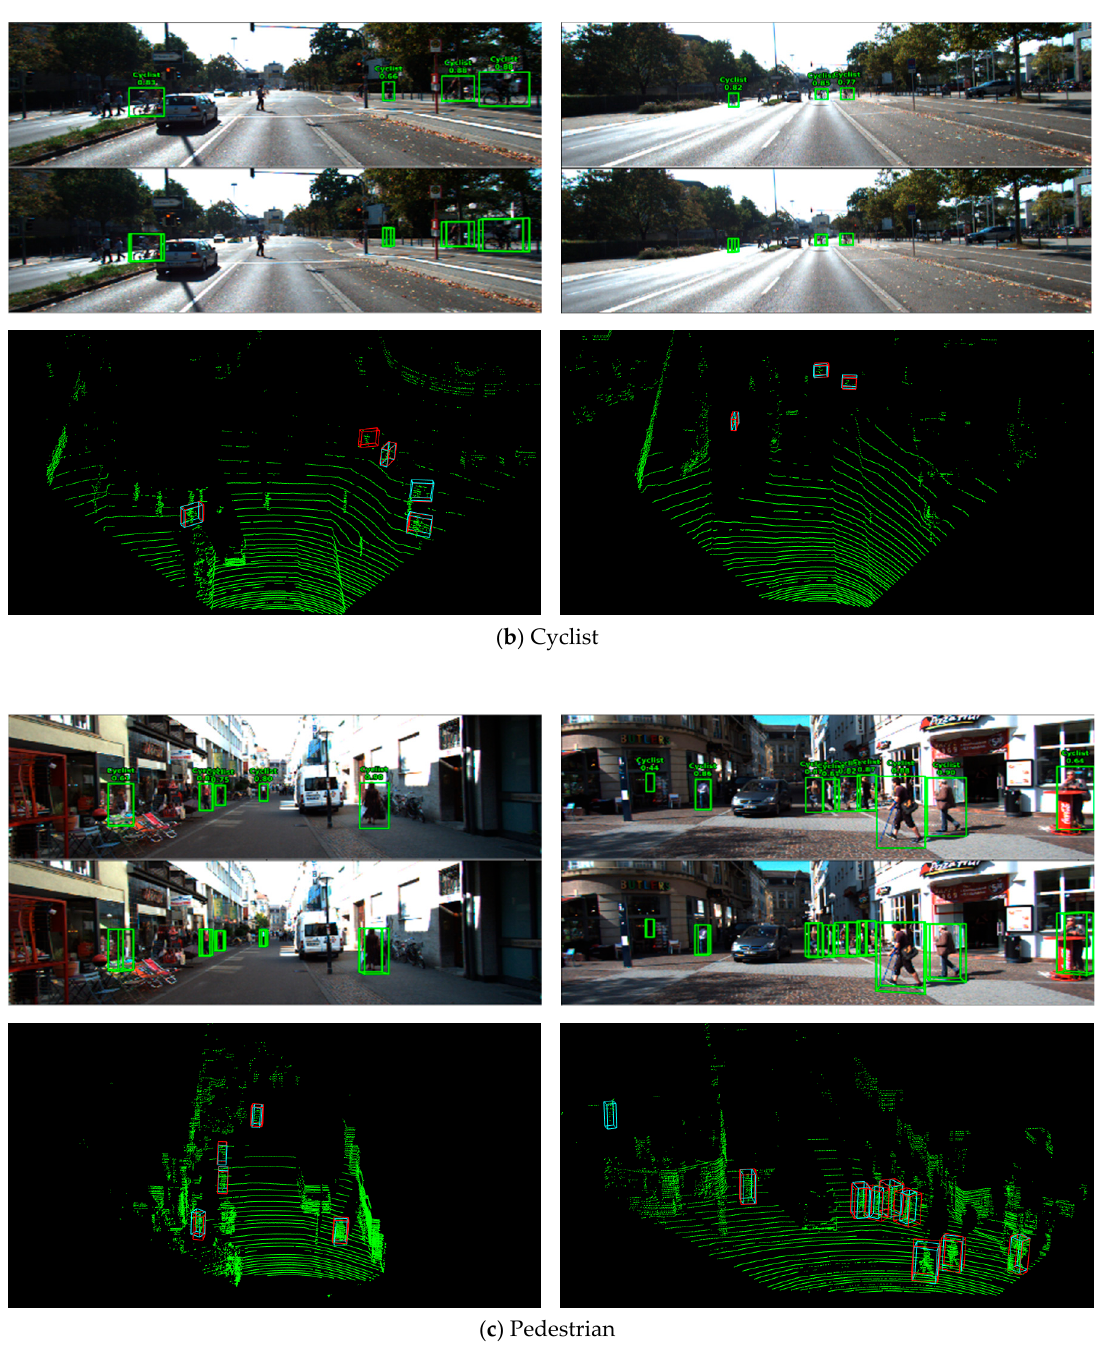
Figure 8. Several 3D detection results on the KITTI validation set. In each RGB image, all the 2D and 3D bounding boxes represent the detection results. The digit and word beside each 2D box represent the instance score and class. In the point clouds, teal 3D boxes indicate detection results, and 3D red boxes represent ground truths.